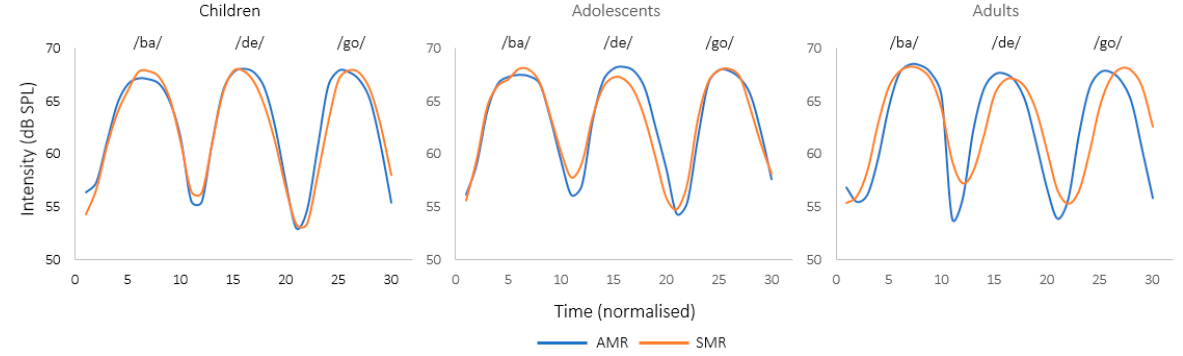
Figure 4. Intensity curves (in dB SPL) for the averaged /ba/, /de/ and /go/ syllables from the AMR and SMR tasks in children, adolescents and